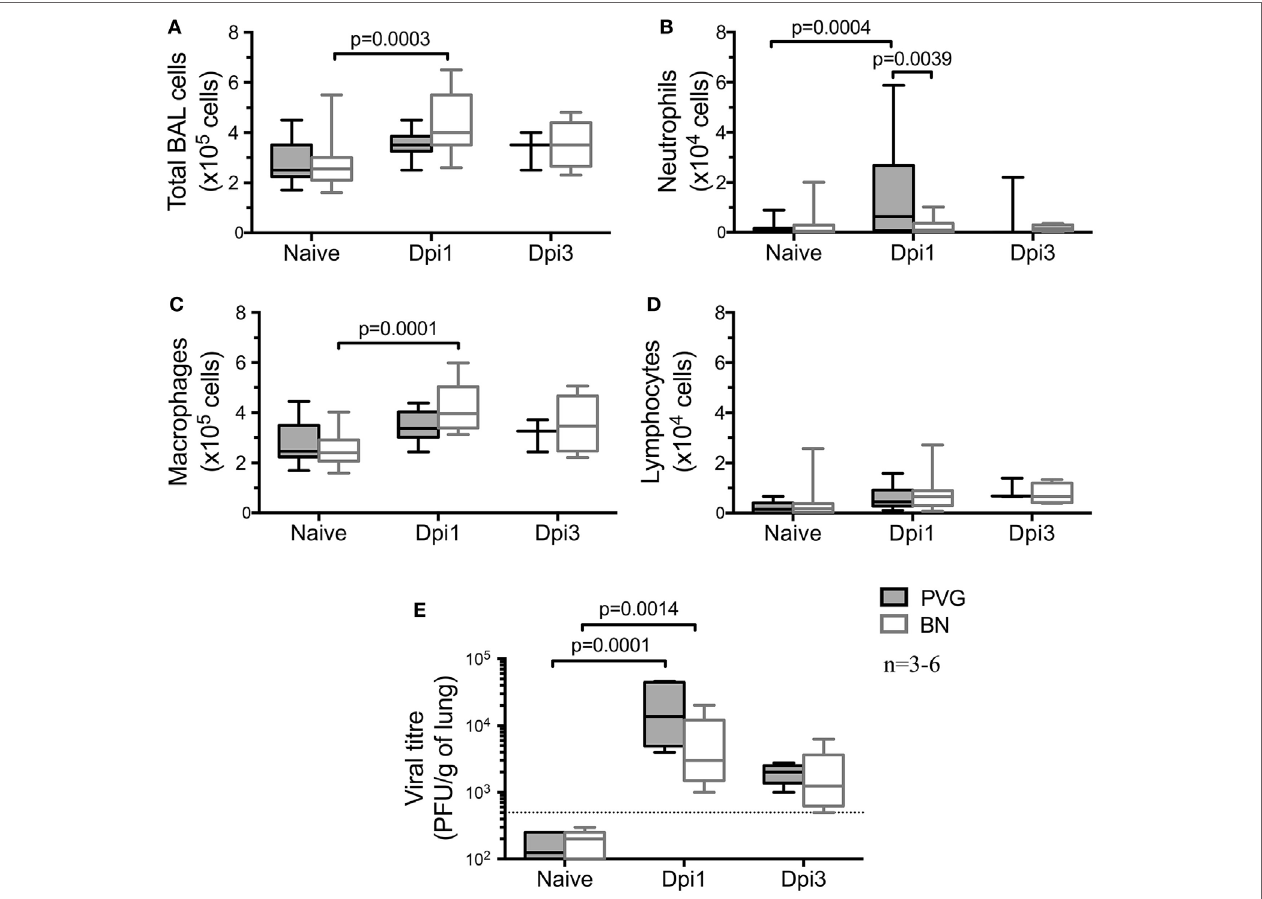
FigUre 1 | vMC 0 -induced airways inflammation in PVG and BN. Bronchoalveolar lavage (BAL) was obtained from naïve PVG ( ◾ ) and BN ( ◽ ) at one and 3 days post-vMC 0 infection (dpi). (a) BAL total cell count, as well as (B) neutrophils, (c) macrophages, and (D) lymphocytes were enumerated using trypan blue and Diff-Quick staining. (e) Viral load was assessed in BAL of PVG and BN by plaque assay ( n = 3–6). Statistical analysis was carried out by non- parametric Kruskal–Wallis test followed by Dunn’s multiple comparisons [overall p -values for panels (a–e) are respectively: 0.0002; 0.0095; 0.0001; 0.0856; and